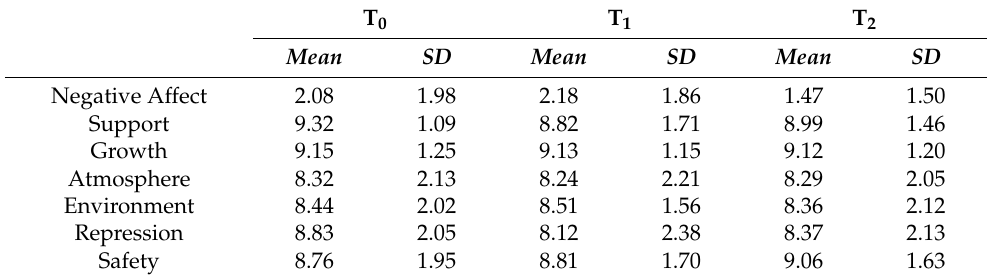
Table 2. Means and standard deviations of VAS-negative affect and classroom